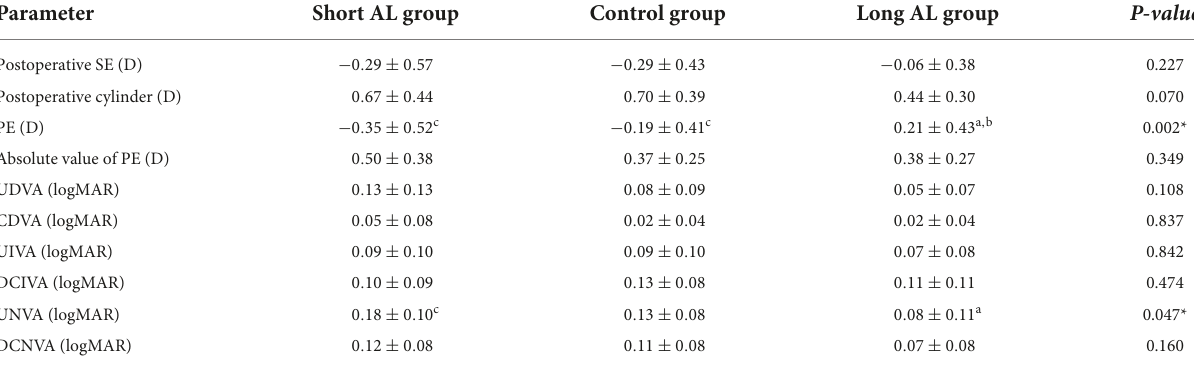
TABLE 2 Refraction and visual